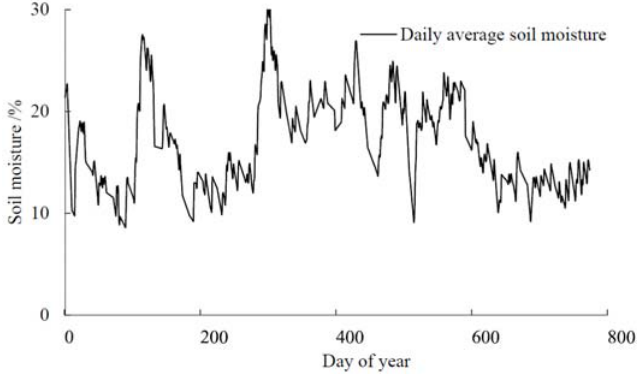
Figure 8. Daily average soil moisture in the validation period.